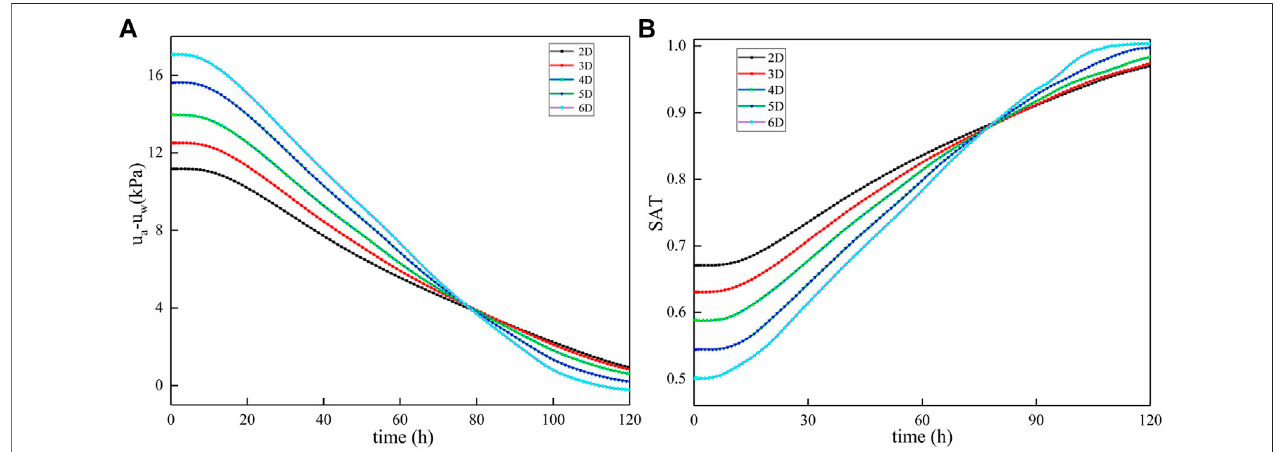
FIGURE 12 | Matrix suction and saturation at monitoring Unit C with different pile spacings.